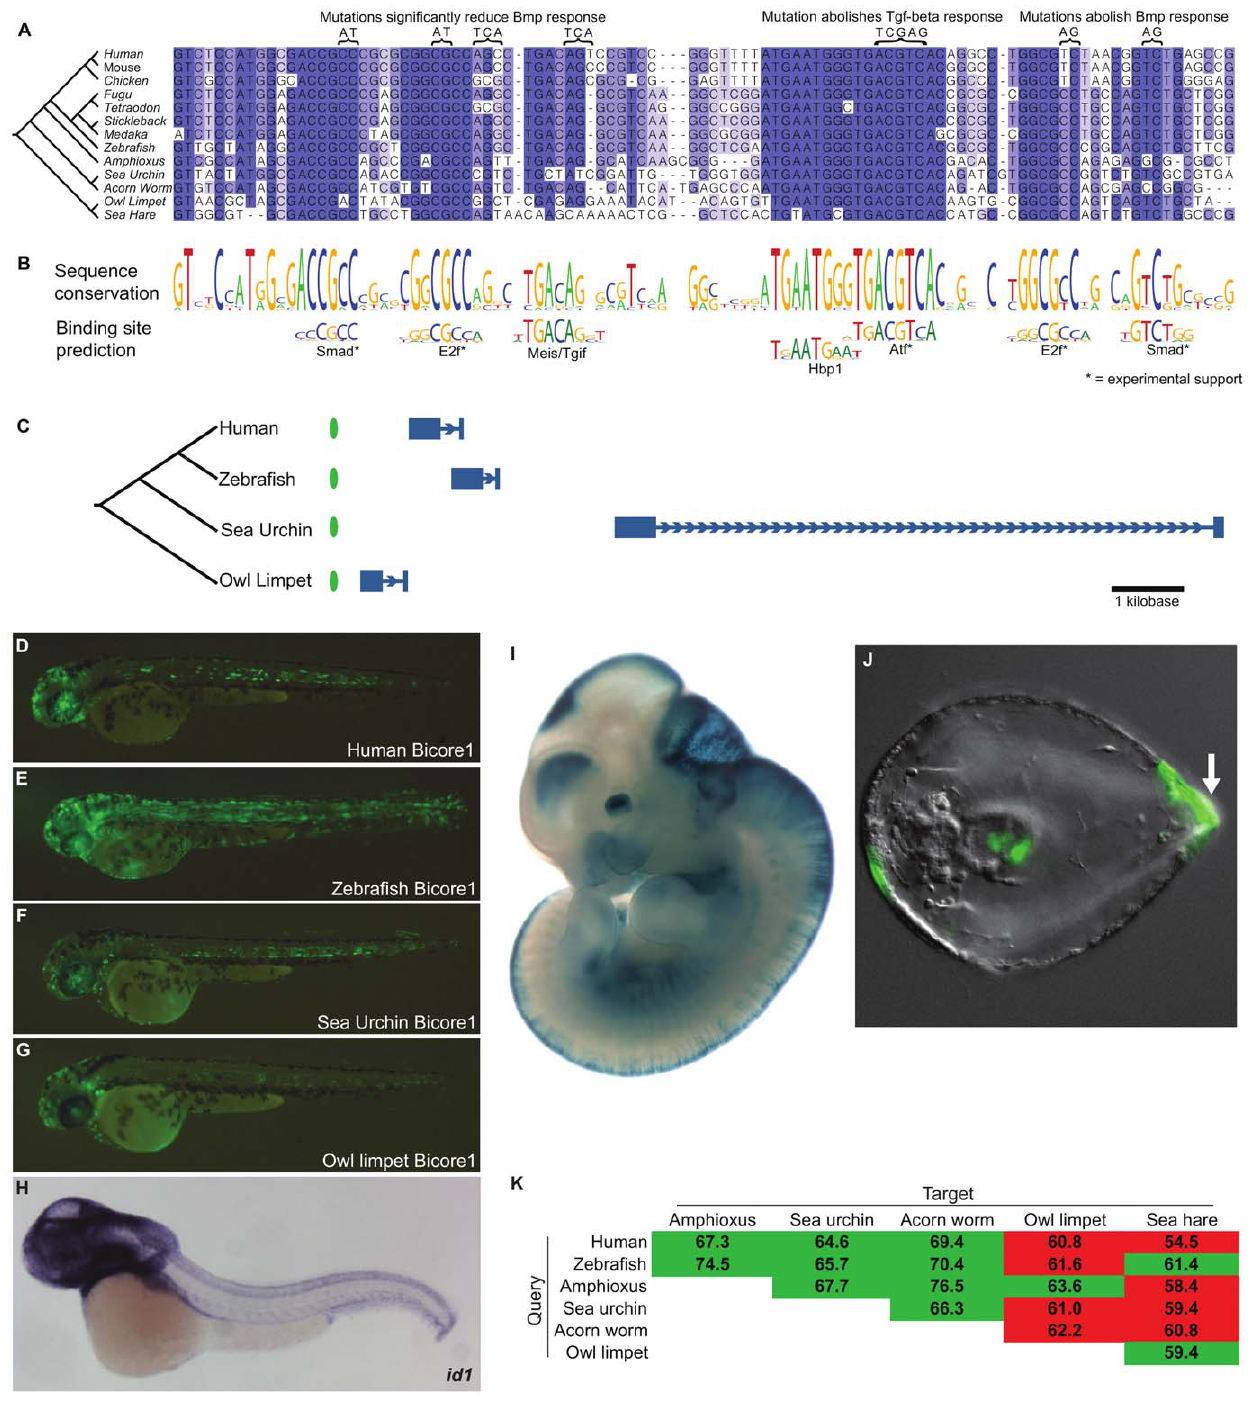
Figure 3. Bicore1 is a bilaterian conserved enhancer. (A) Multiple alignment of Bicore1. Above the alignment are mutations that reduce the cis - regulatory function of Bicore1 in response to Tgf-beta/Bmp signaling in a luciferase assay [20,21,24]. (B) Conservation profile of Bicore1 showing that conserved blocks in the alignment correspond to transcription factor binding preferences. (C) Each instance of Bicore1 (green oval) is syntenic to a conserved Id gene (blue gene structure). (D–G) Zebrafish transgenic assay showing (D) human, (E) zebrafish, (F) sea urchin, (G) owl limpet instances of Bicore1 drive expression in the central nervous system at 48 hours. (H) Whole-mount in situ hybridization of id1 in zebrafish shows expression throughout the central nervous system, courtesy of zfin.org. (I) A human genomic region containing Bicore1 drives expression in the forebrain, midbrain, hindbrain, neural tube, and eye of embryonic day 11.5 mice, courtesy of enhancer.lbl.gov. (J) A sea urchin genomic region drives expression in the aboral ectoderm (arrow) in the early pluteus stage sea urchin larva. (K) Pairwise percent identities of Bicore1 sequences. Green cells indicate a query sequence (row) that detected Bicore1 in the target (column). Red cells indicate query sequences that did not detect Bicore1 in the target.